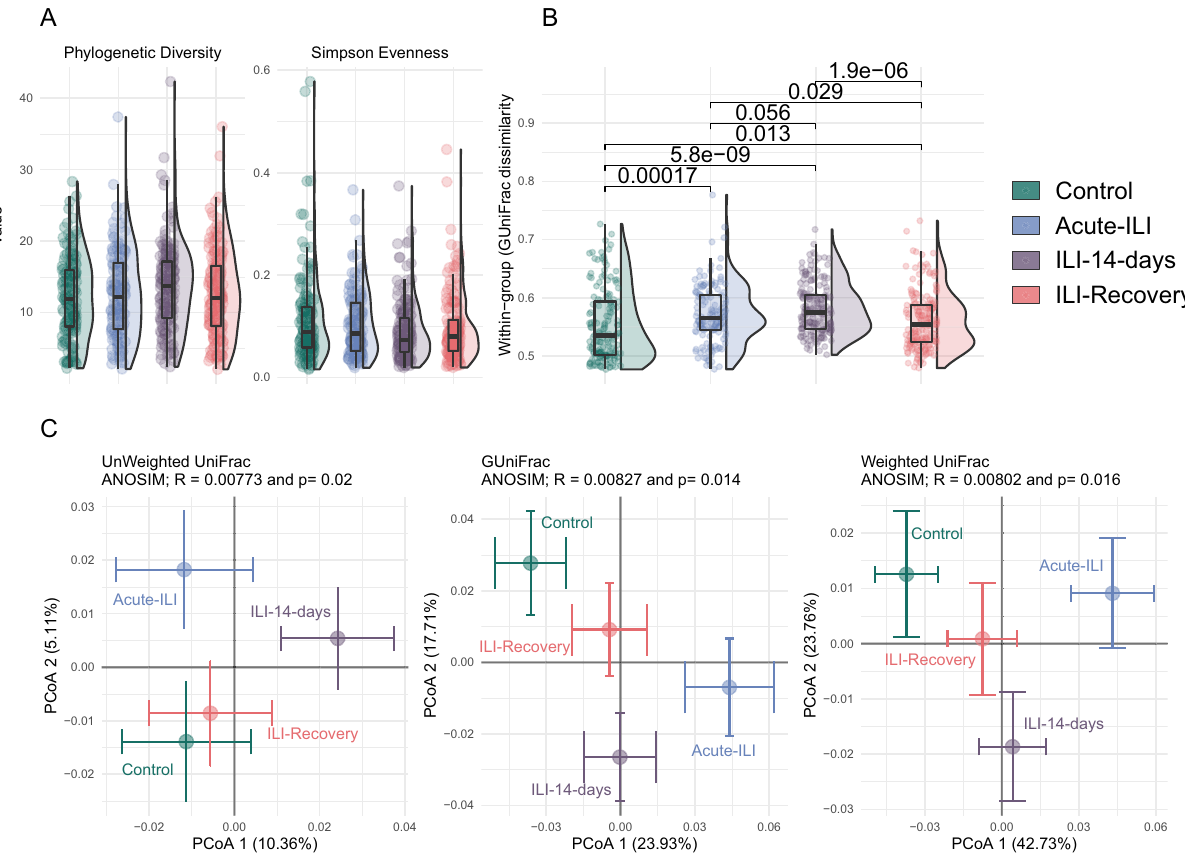
Figure 1. Comparison of diversity between groups. ( A ) Alpha diversity measures, phylogenetic diversity and evenness comparisons between groups. ( B ) Inter-individual variation in community composition based on generalized UniFrac distances between samples within a group. Statistical comparisons are based on Wilcoxon rank-sum test, corrected for multiple comparisons using Benjamini–Hochberg Procedure. ( C ) Comparison of beta-diversity between groups based on Unweighted, Generalized and Weighted UniFrac distances, with centroids and bars representing standard error across the two